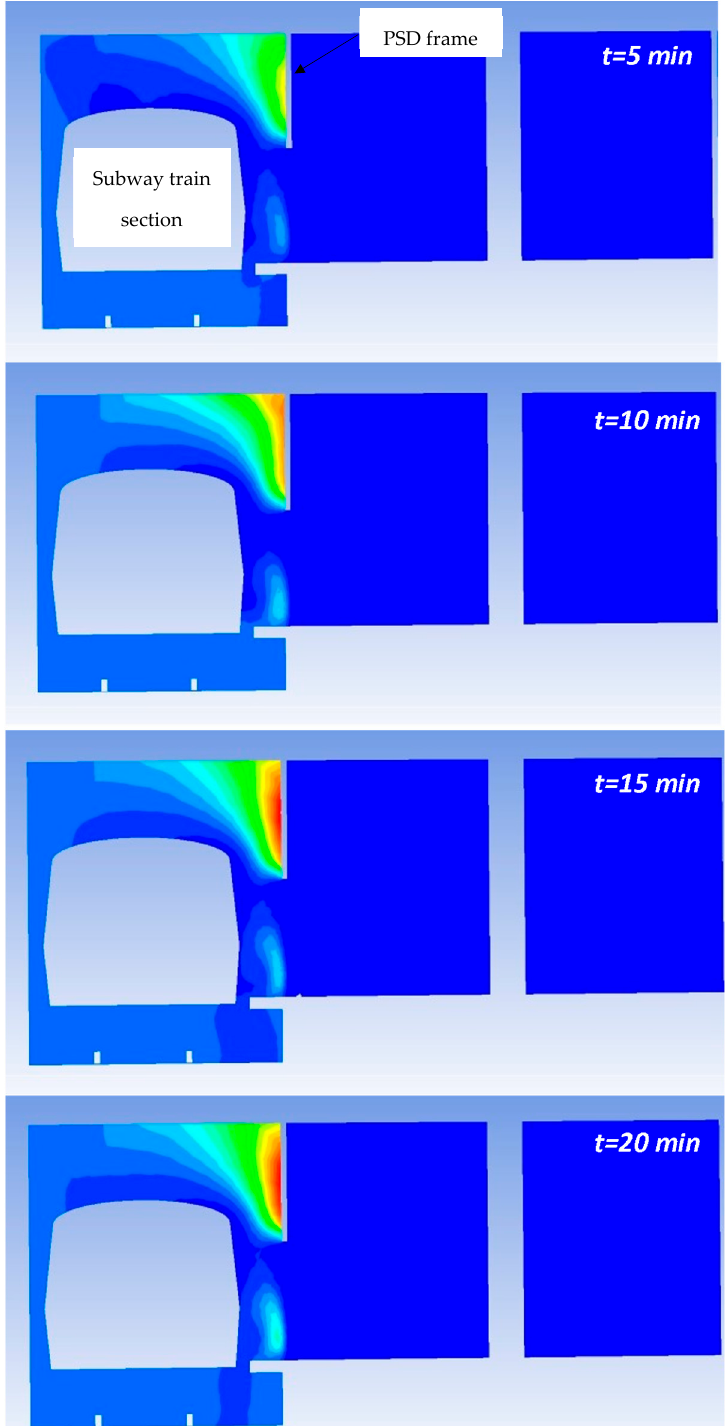
Figure 21. CO contours (ppm)—cross section through the door of the PSD system near the fire outbreak (minutes 5–20).